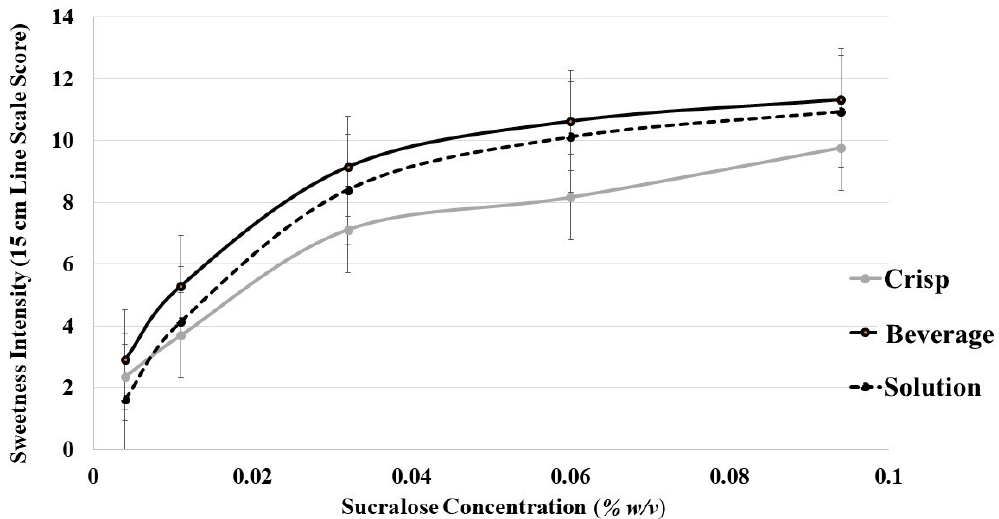
Figure 2. Sweet intensity perception over the range of sucralose concentrations for sucralose solutions, oat beverage, and oat crisps. Sweetness intensity was perceived as higher in oat milk compared to oat crisps, regardless of degree of sweetness ( p < 0.001). The error bars represent the standard error of the mean.